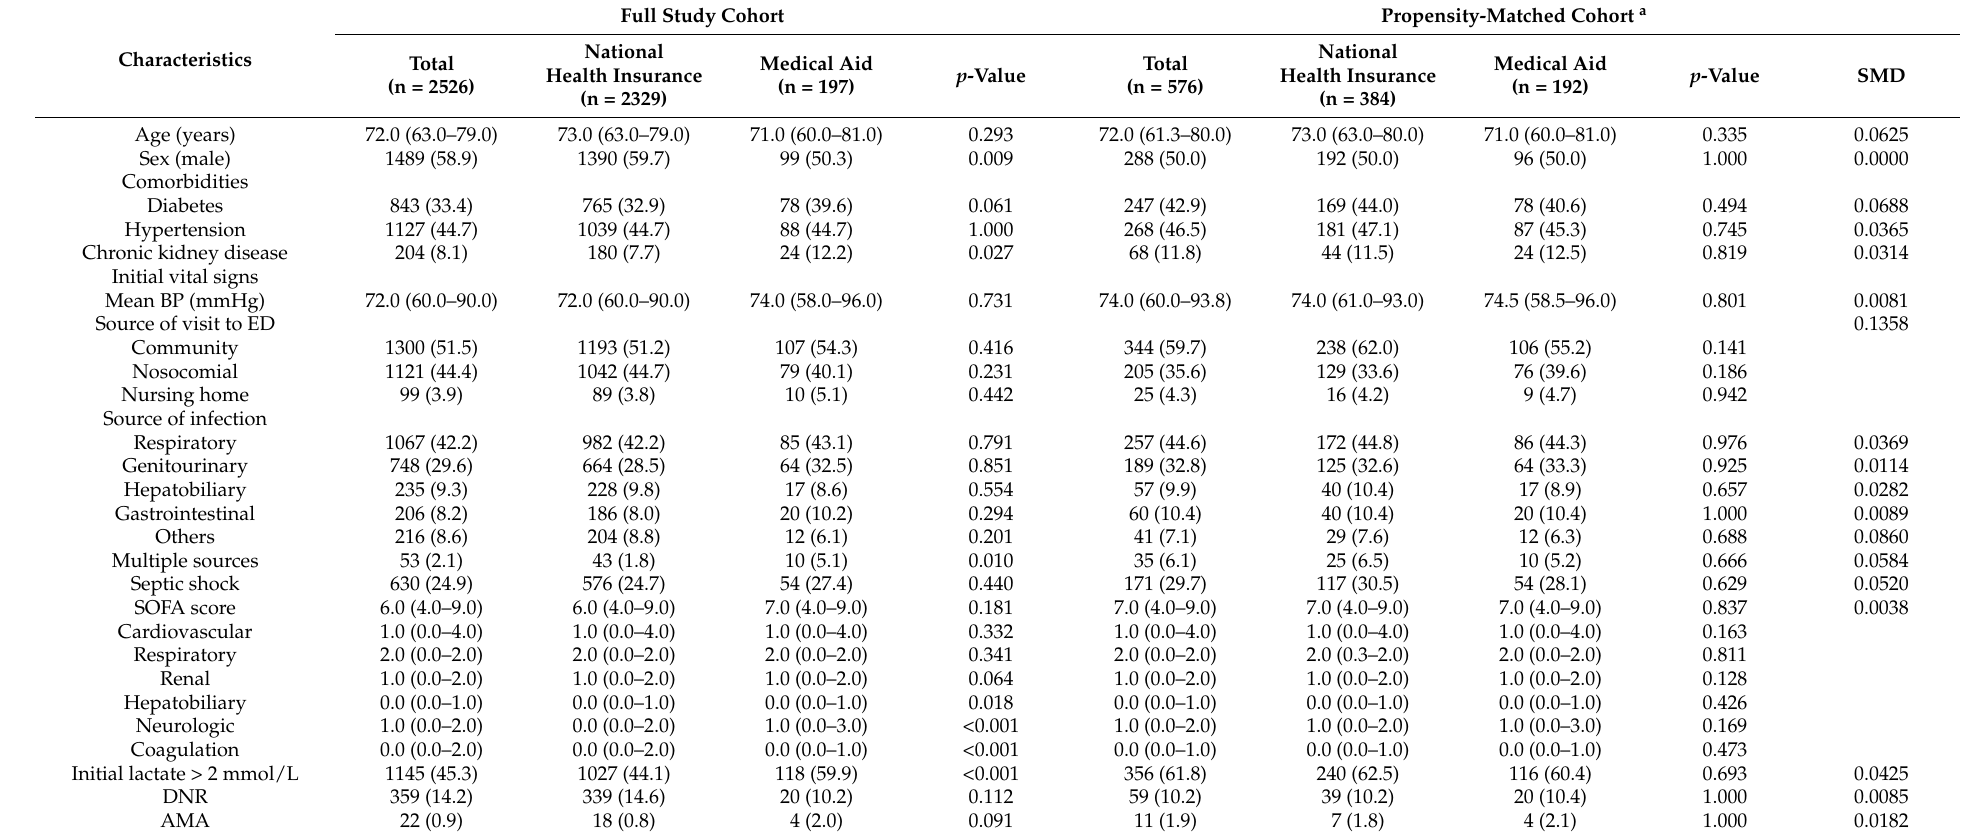
Table 1. Patient characteristics of the full study cohort and propensity-matched